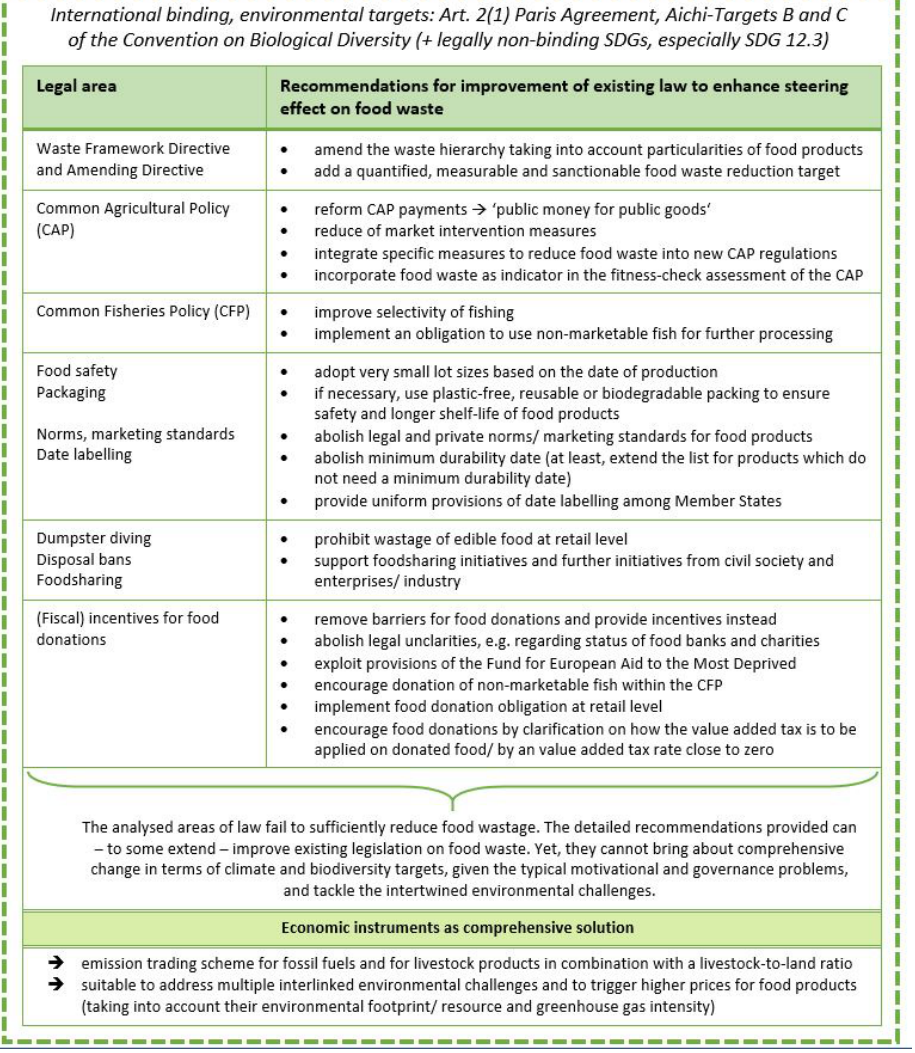
Figure 1. Recommendations for improvement of existing law and economic instruments as alternative to tackle food